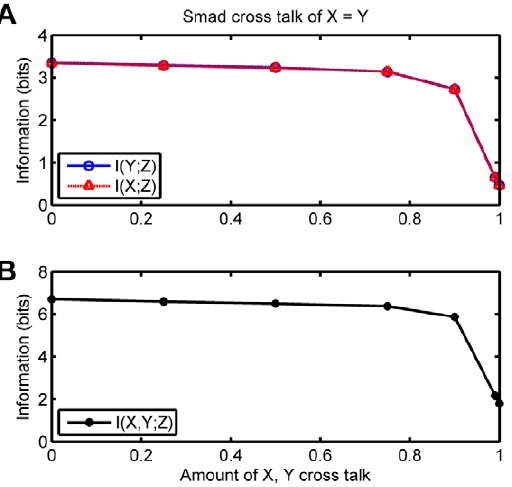
Figure 5. Information in bits vs fraction of cross-talk for the Smad Model C, with equal cross talk. Note that cross-talk is defined as the ratio of the on-rate of a Smad protein for the non- cognate receptor to the on-rate for its cognate receptor. When cross- talk is zero, only the cognate receptor can phosphorylate the Smad; when cross-talk is one, both receptors are equally efficient in phosphorylation of that Smad. In this plot the cross-talk between the receptor for X and output Z 2 is the same as that between the receptor for Y with output Z 1 . ( A ) Partial mutual information. ( B ) Total mutual information.